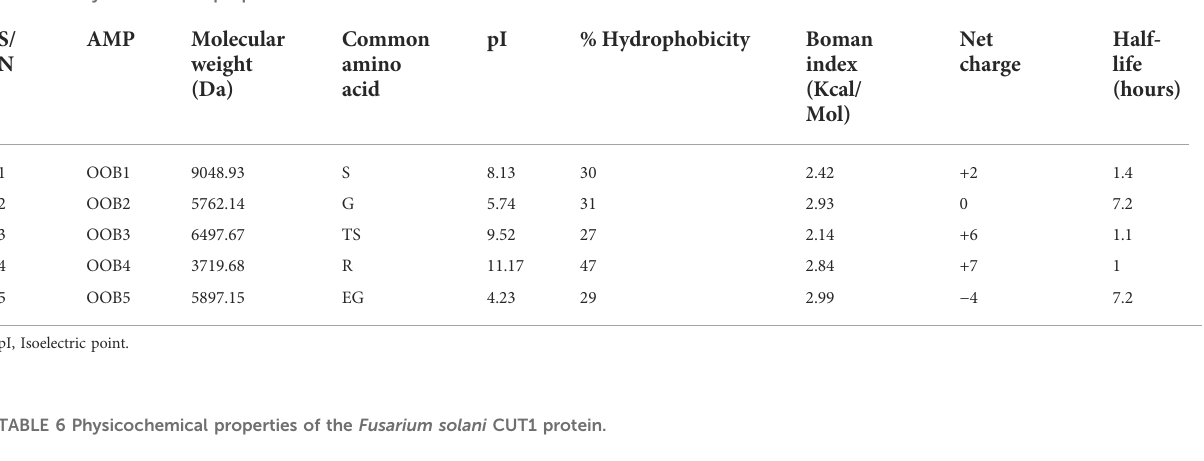
TABLE 6 Physicochemical properties of the Fusarium solani CUT1 protein. S/ Molecular N weight